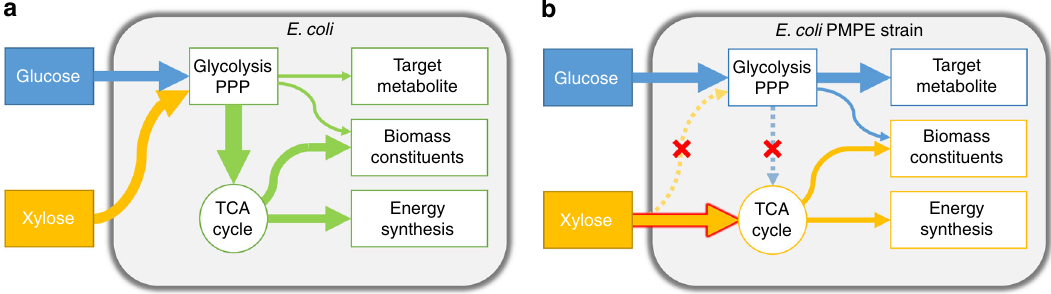
Fig. 1 The concept of parallel metabolic pathway engineering. a Glucose and xylose carbon fl uxes in common strains. Glucose and xylose are catabolized by the same pathways, glycolysis and the pentose phosphate pathway, and a large amount of the liberated carbon is used to synthesize biomass constituents and produce energy. b Glucose and xylose carbon fl uxes in the engineered parallel metabolic pathway strain. Metabolic pathways of glucose and xylose do not intersect, making them metabolically parallel. Blue, yellow, and green arrows represent carbon fl ow from glucose, xylose, and both, respectively. The red-bordered yellow arrow represents the introduced exogenous xylose catabolite pathway. The thickness of arrows represents the proportion of carbon fl ow. Red crosses and dotted lines indicate the disruption of metabolic